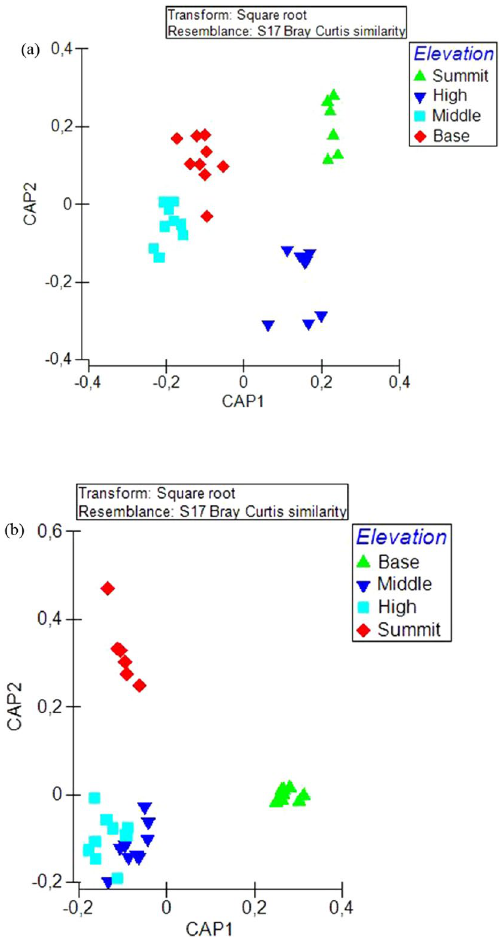
Figure 6. Canonical analysis of principal coordinate showing differences in ( a ) flower visiting insect species composition, and ( b ) flowering plant species composition across elevation zones. CAP plot was computed using Bray-Curtis similarity index obtained from the square-root transformation of abundance